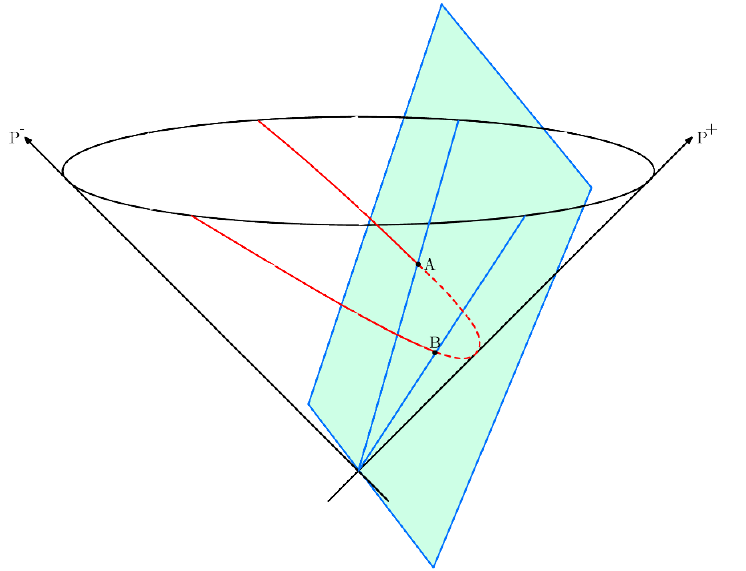
Figure 2 . The intersection of a hyperplane (not containing P + (cid:0) axis ) with the Poincar(cid:19)e section (denoted here by a pair of points A and B) of the null-cone in embedding space leads to spherical defect in the physical